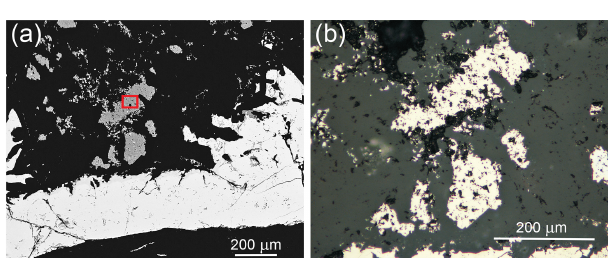
reflected light, grimmite is creamy grey with a pinkish tint.